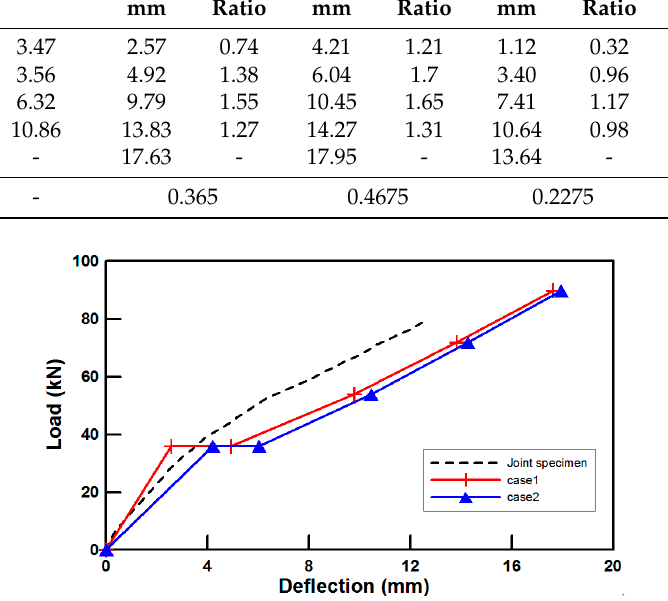
Figure 9. Load and deflection curves of Cases 1 and 2.